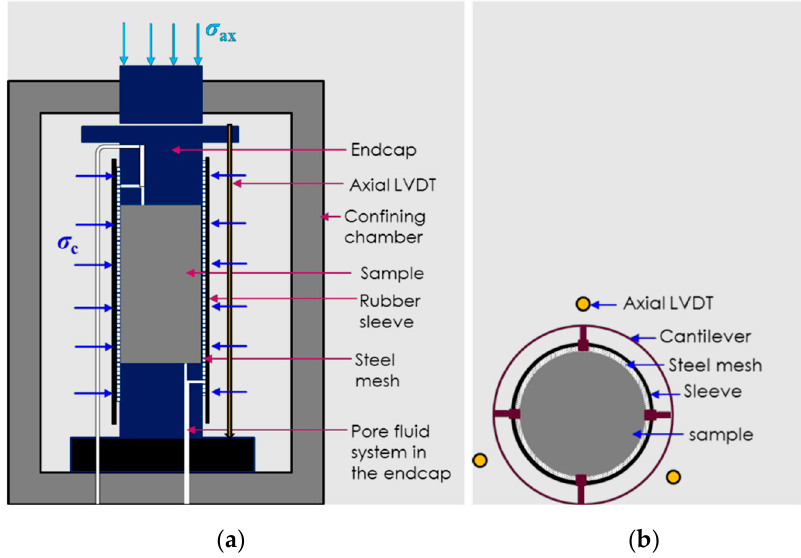
Figure 1. Triaxial cell for small samples. ( a ) axial cut schematically showing the positioning of the shale specimen, steel mesh to distribute pore fluid, surrounding rubber sleeve and fluid lines in the pistons; ( b ) cross section showing instrumentation consisting of linear variable displacement transducers (LVDTs) and cantilevers for axial and radial displacement, respectively.